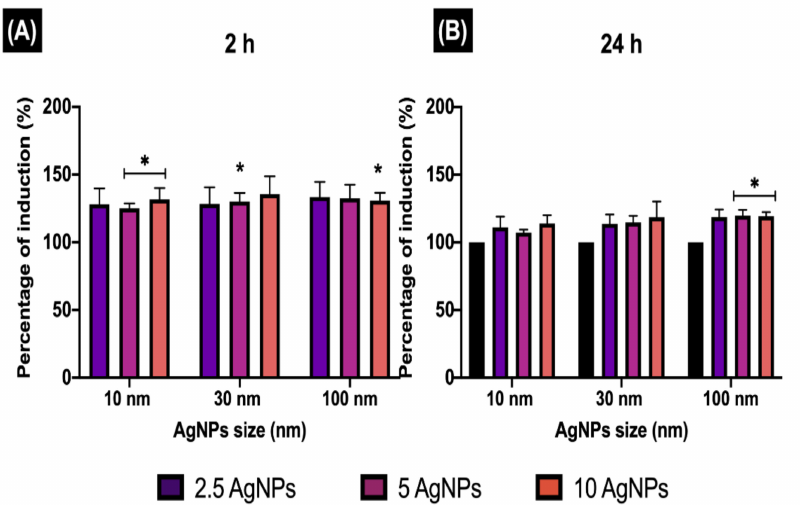
Figure 6. Early endosome induction. The percentage of EE induction (EEI) in ZF4 cells treated with 2.5, 5, and 10 µ g/mL of three different AgNP sizes (10, 30, and 100 nm) after ( A ) 2 and ( B ) 24 h. The intensity results were normalised to percentage (%) relative to the untreated cells (naive) (see Materials and Methods Section 2.6 for calculation). Data represent the mean of three individual replicates and above the bars the standard deviation (Mean ± SD). Data with asterisks (*) indicate a statistical difference (* p < 0.05) between the treatments compared to the untreated control (naive) at the specific